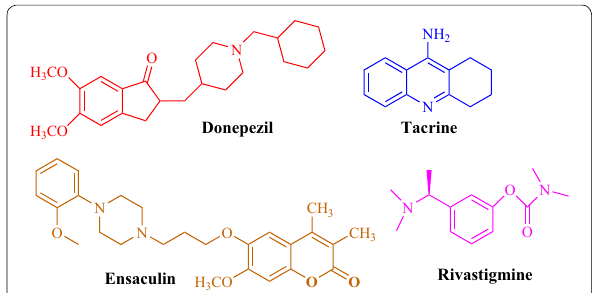
Fig. 12 Structures of the acetylcholinesterase inhibitors as FDA approved Alzheimer’s disease therapeutics